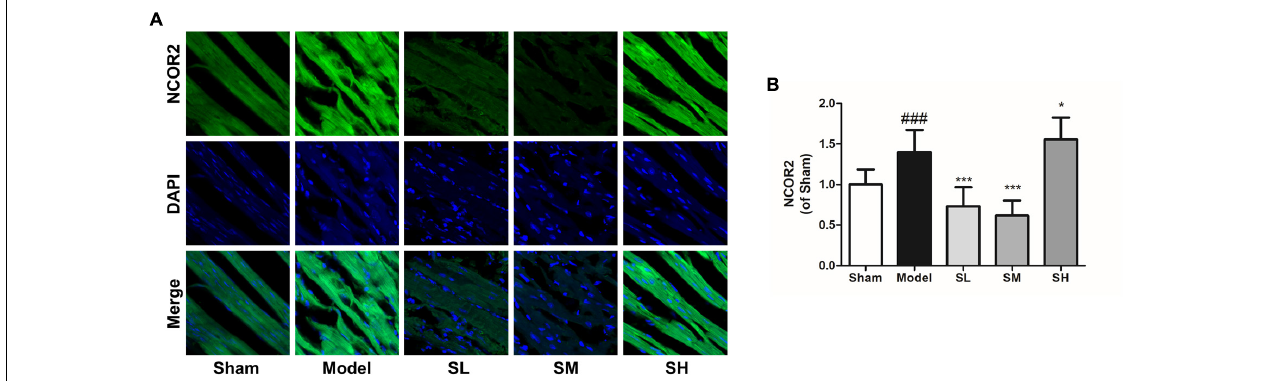
FIGURE 13 | The immunofluorescence of NCOR2 in the heart tissue after the treatment of Schisandra . (A) The immunofluorescence staining of NCOR2 in heart tissue (400 × ); (B) the quantitation of NCOR2 from immunofluorescence staining results. All data are shown as the mean ± SD, ### P < 0.001 vs. Sham group; ∗ P < 0.05, ∗∗∗ P < 0.001 vs. Model